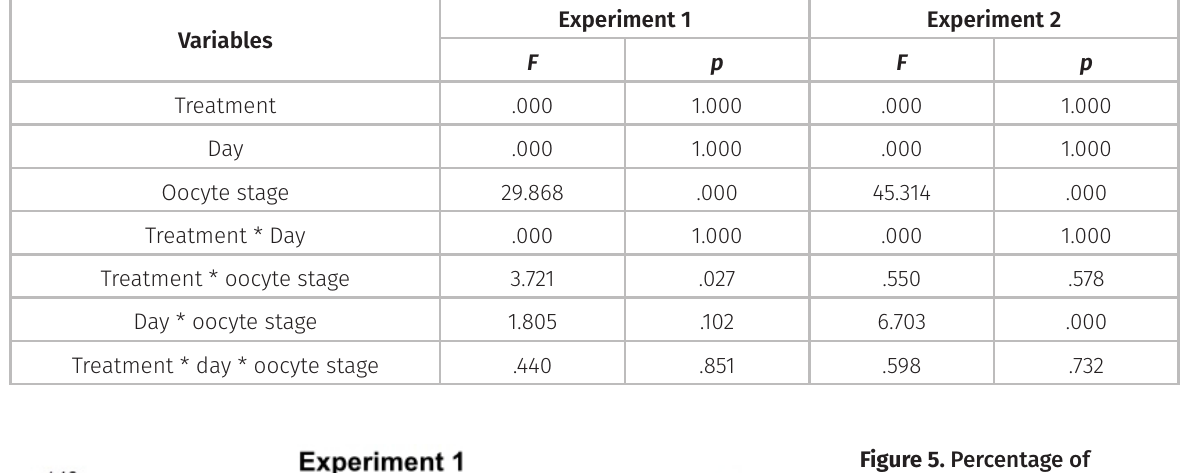
Figure 5. Percentage of area occupied by different developmental stages of oocytes of Macrobrachium acanthurus in experiments 1 and 2. Atretic oocyte - At;